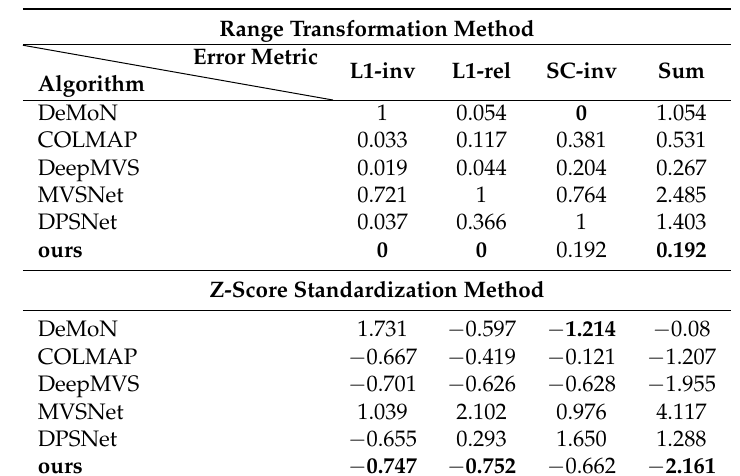
Table 2. The result of normalization of data. The best one is highlighted in bold.